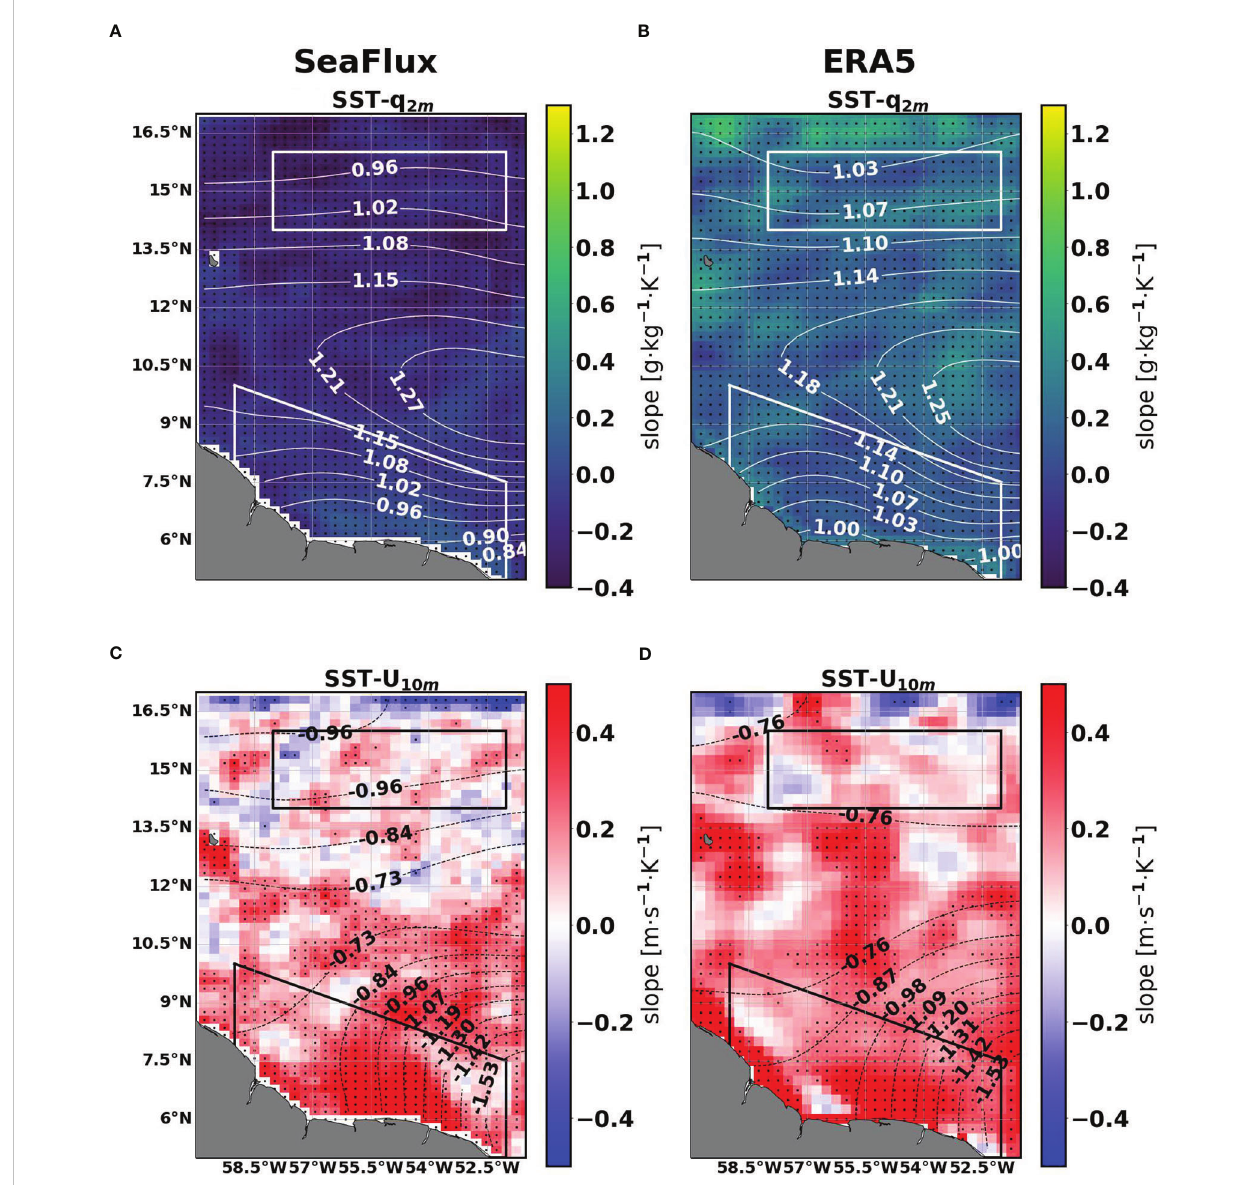
FIGURE 3 Spatial distribution of the and SST-q 2m and SST-U 10m linear regression slopes for SeaFlux (left column panels) and ERA5 (right column panels). (A, B) represent the SST-q 2m linear regression slopes for the smoothed (contours, in g kg − 1 K − 1 and in white to facilitate visualization) and residual fi elds (shading). (C, D) represent the SST-U 10m linear regression slopes for the smoothed (contours, in m s − 1 K − 1 ) and residual fi elds (shading). In all the cases, the hatching marks the slopes from the residual fi elds which are statistically signi fi cant at a 99% con fi dence interval after a two-sided t-test. All the panels are obtained considering daily data during the 2008-2018 DJF season. The s value introduced in the Gaussian fi lter equals 150 km. In all the maps the OOR and the ECR are delimited by the northern and coastal boxes